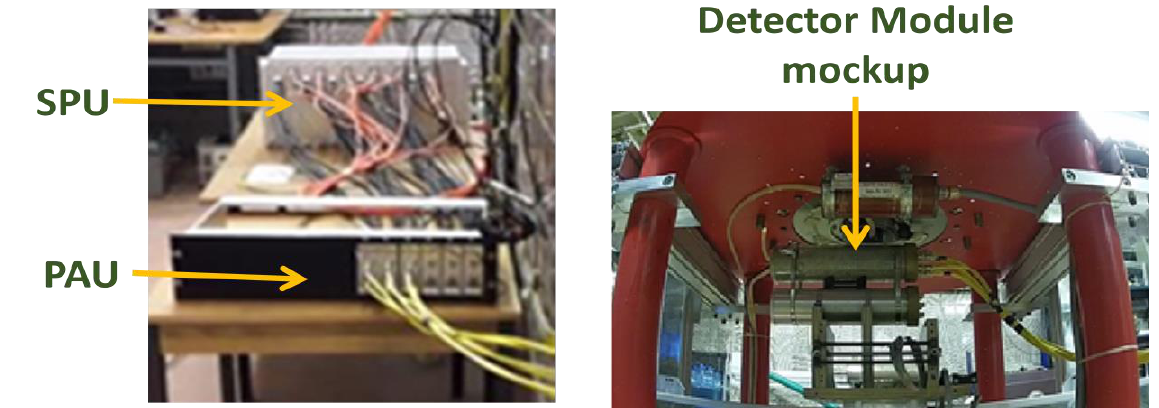
Fig. 2. Images of the equipment during tests at the plasma neutron diagnostics